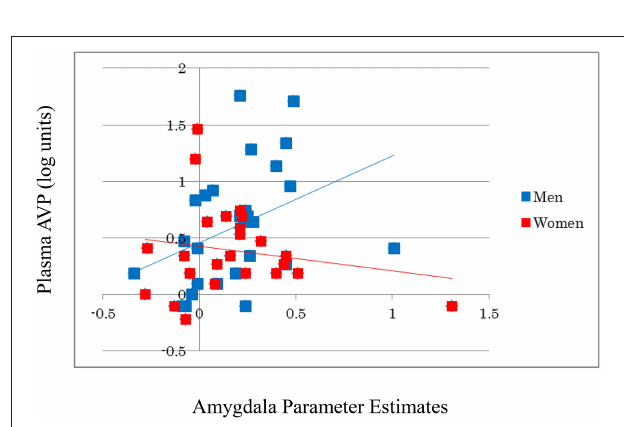
FIGURE 2 | A significant positive correlation is observed between the log-transformed plasma AVP values and amygdala activity during emotion generation (Look Negative–Look Neutral) in men, but not in women. For illustration purposes, scatter plots are unadjusted for any